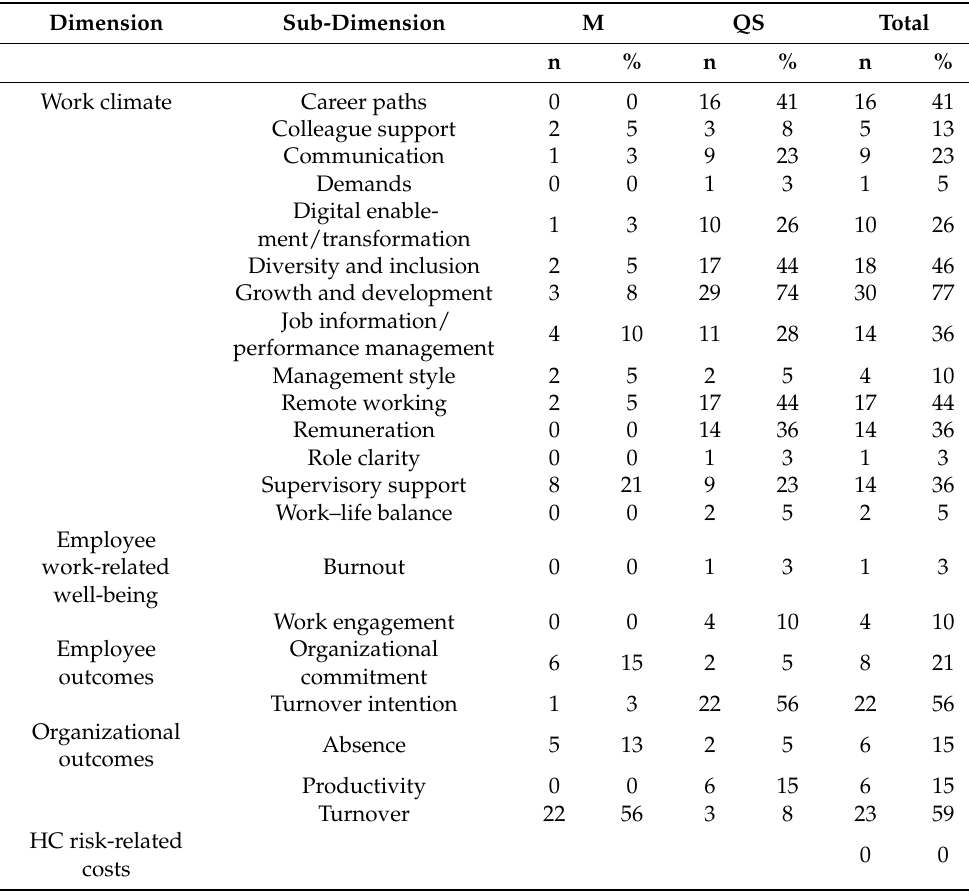
Table 3. Category 2: Risks